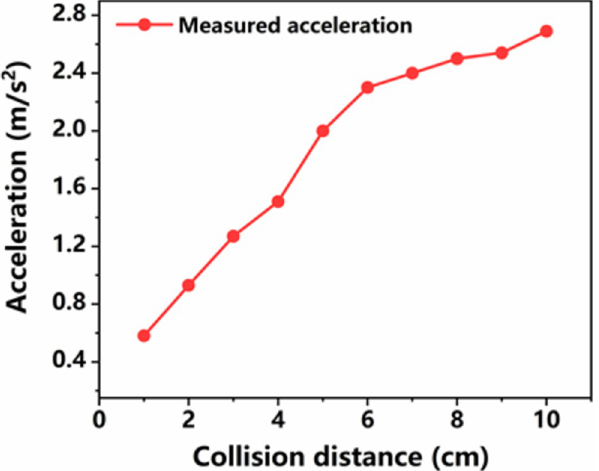
Fig 7. The measured acceleration by freeing the Ping-Pong ball with different collision